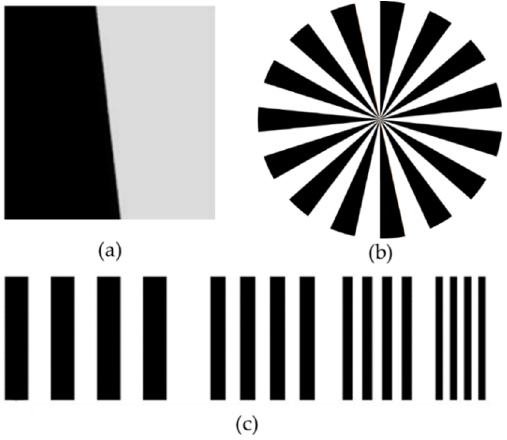
Figure 1. ( a ) Slanted-edge pattern, ( b ) Siemens star pattern, and ( c ) Sinusoidal pattern.